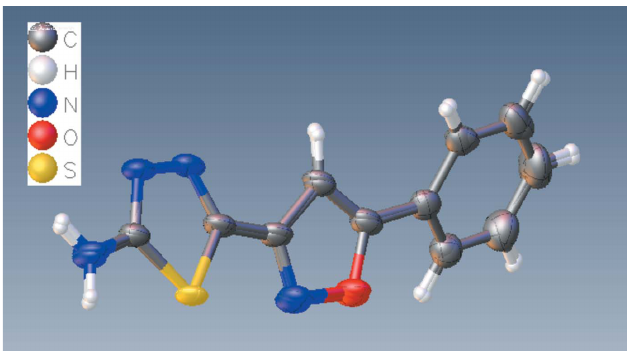
Figure 3 Aview of the intermolecular N—H (cid:2)(cid:2)(cid:2) N and C—H (cid:2)(cid:2)(cid:2) N interactions in the crystal structure of the title compound projected along the a